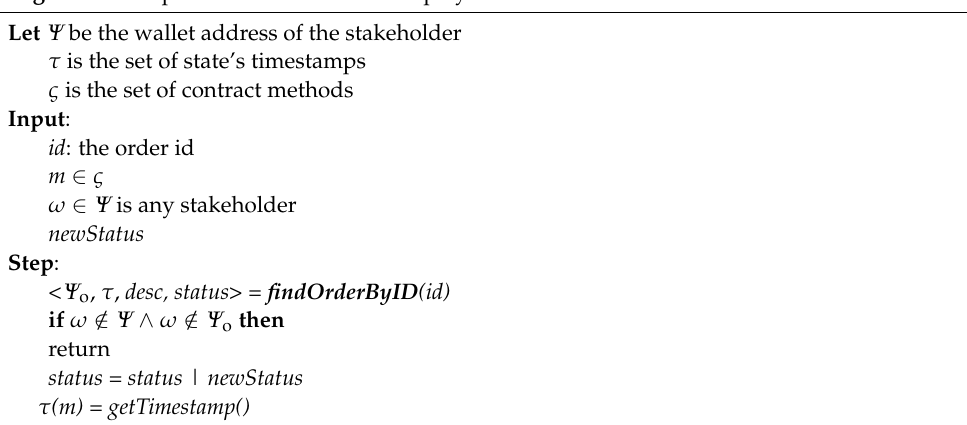
Algorithm 2. Update status and timestamp by